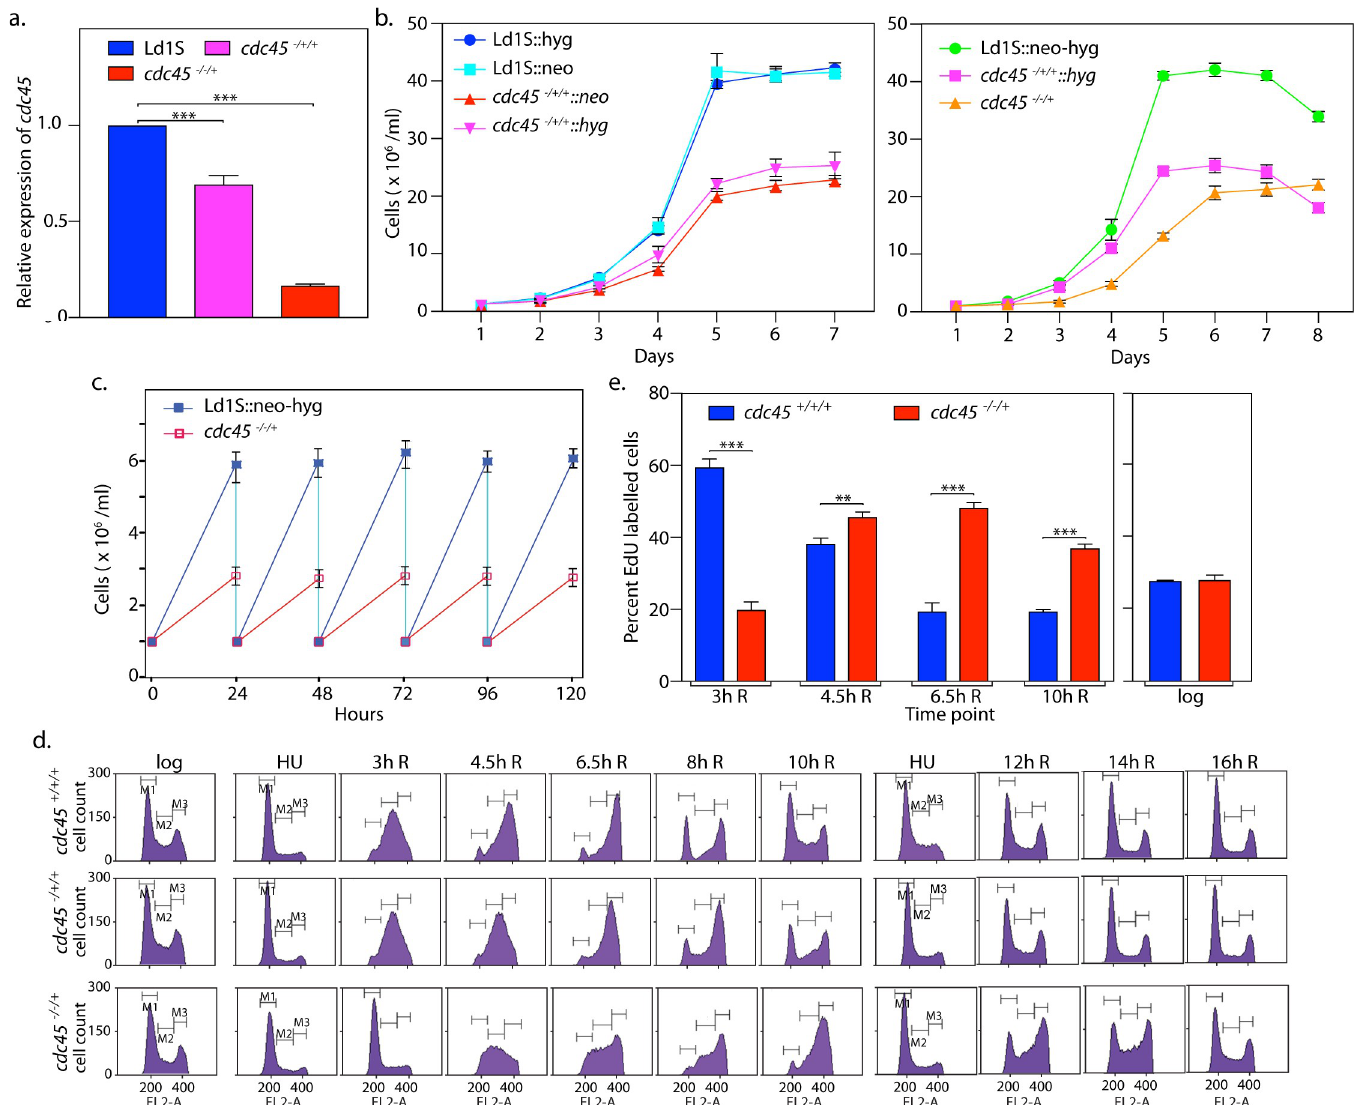
Fig 1. Depletion of Cdc45 causes growth and cell cycle aberrations. a. Analysis of cdc45 expression in genomic knockout lines using real time PCR analysis. Tubulin served as internal control. cdc45 -/+/+ refers to cdc45 -/+/+ ::hyg cells. The average of data from three experiments is presented here. Error bars represent standard deviation. Two-tailed student’s t-test was applied: ��� p < 0.0005. b. Analysis of growth of Cdc45-depleted cells. Growth was initiated at 1x10 6 cells/ml, from stationary phase cells. Left panel: single allele replacement lines compared to control cells. Ld1S::hyg and Ld1S::neo are control Ld1S cells harboring the hyg r and neo r genes respectively, previously found to grow at rates comparable to wild type Ld1S cells. Right panel: double allele and single allele replacement lines compared to control cells. Ld1S::neo- hyg are control Ld1S cells expressing both neo r and hyg r casettes, previously found to grow at rates comparable to wild type Ld1S cells. In each case three experiments were set up in parallel and the graphs represent average values, with error bars representing standard deviation. c. Determination of generation time of double allele replacement cells cdc45 -/-/+ in comparison with control Ld1S::neo-hyg cells. Growth initiated at 1x10 6 cells/ml from exponentially growing promastigotes, and cells diluted to 1x10 6 cells/ml every 24 hours. Average of three experiments are plotted, and error bars depict standard deviation. d. Flow cytometry analysis of Cdc45-depleted cells in comparison with control cells. Cells were synchronized at G1/S by HU treatment and then released into S phase. Time-points at which cells were sampled are indicated above each column of histograms e . g . 3h R signifies 3 hours after release from HU. M1, M2 and M3 gates represent cells in G1, S and G2/M respectively. 30000 events were counted in each case. cdc45 +/+/+ —Ld1S::neo-hyg cells. cdc45 -/+/+ — cdc45 -/+/+ :: hyg (heterozygous) knockout cells. cdc45 -/-/+ — cdc45 double allele knockout cells. The experiment was done thrice, and one data set is presented here. The percentage of gated cells in each of the cell cycle stages (G1, S and G2/M) from all three experiments are tabulated in S1 Table. e. HU-treated cells were released into S phase and 1 ml aliquots pulsed with EdU for 15 min. Left panel: Pulsing with EdU 3 hours, 4.5 hours, 6.5 hours and 10 hours after release. Right panel: Pulsing logarithmically growing cells with EdU. cdc45 +/+/+ —Ld1S::neo-hyg cells. Data presented in bar chart are average of three experiments and error bars represent standard deviation. Two-tailed student’s t-test was applied: �� p < 0.005, ��� p < 0.0005.